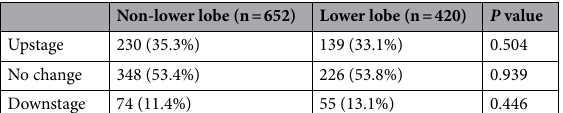
Table 3. Stage shift from clinical to pathologic stage in the patients who underwent complete resection.